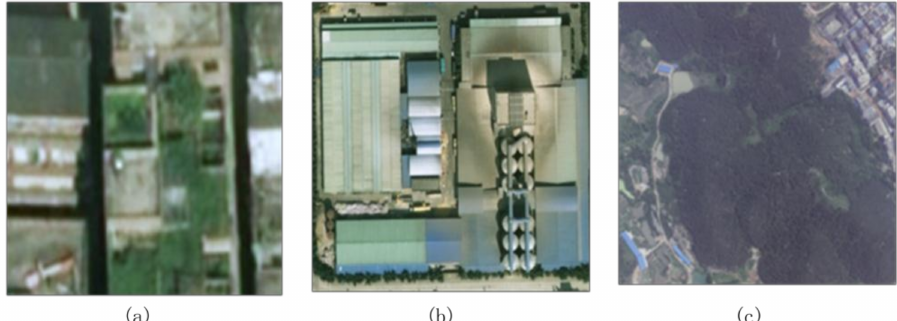
Figure 4. Roof and vegetation indistinguishable by color alone. ( a ) Vegetation-covered roof; ( b ) Green house; and, ( c ) Dark vegetation as a result of tone